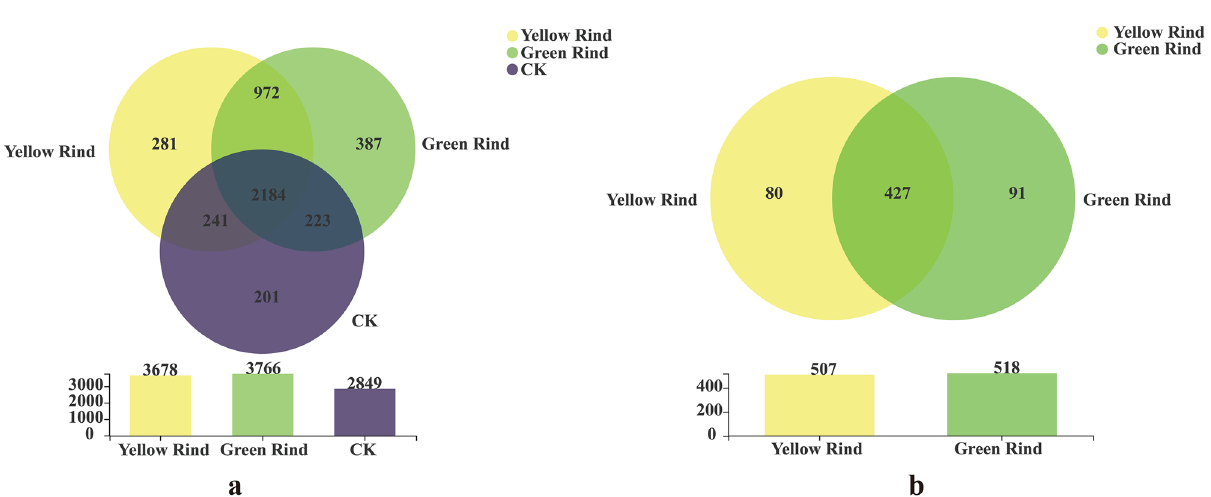
Figure 9. Venn diagrams of the soil dominant bacteria in rhizosphere ( a ) and endophytic ( b ) bacteria of yellow and green rind watermelons at OTU level.